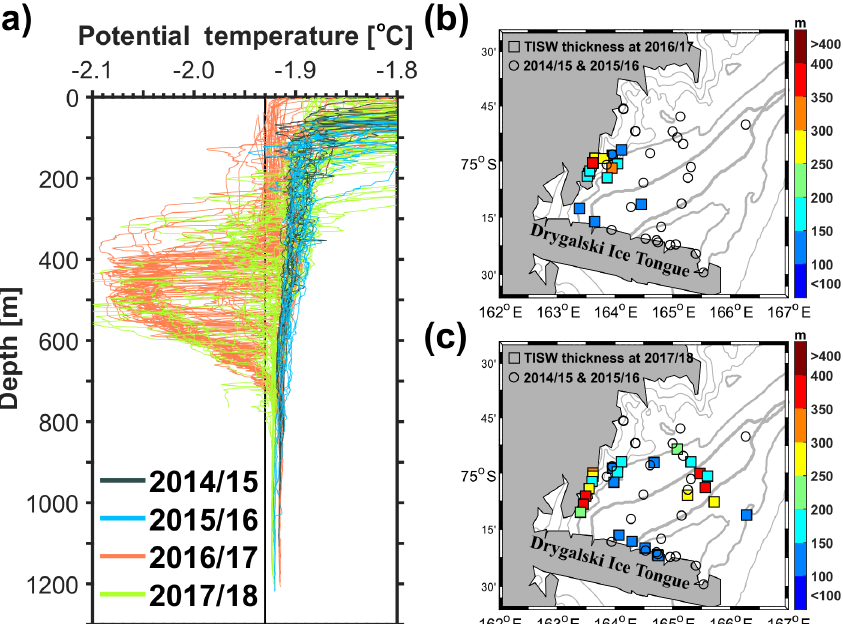
Figure 13. (a) The same as Fig. 7a, but for potential temperature; the black solid line denotes − 1 . 93 ◦ C. (b) Distributions of Terra Nova Bay ice shelf water (potential temperature < − 1 . 93 ◦ C) thickness (m) in vertical CTD profiles during the 2016/17 survey (see details in Table 1). The bold gray line indicates the 1000m isobaths, and the interval between the thinner gray lines is 200m. (c) The same as Fig. 13b, but for the 2017/18 survey.